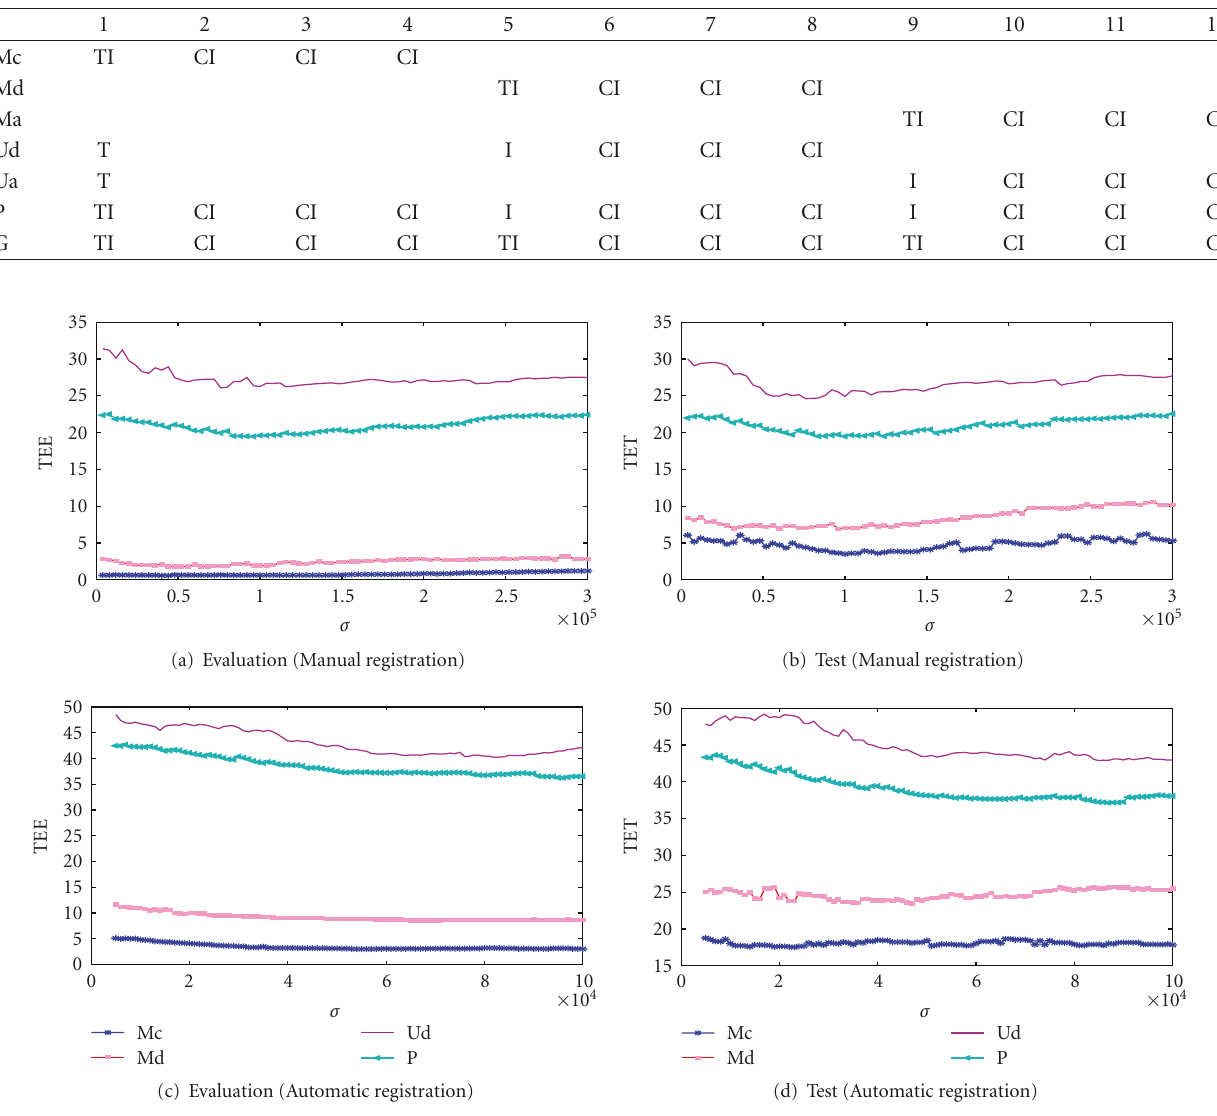
Figure 1: The performance of the GD metric versus the value of σ